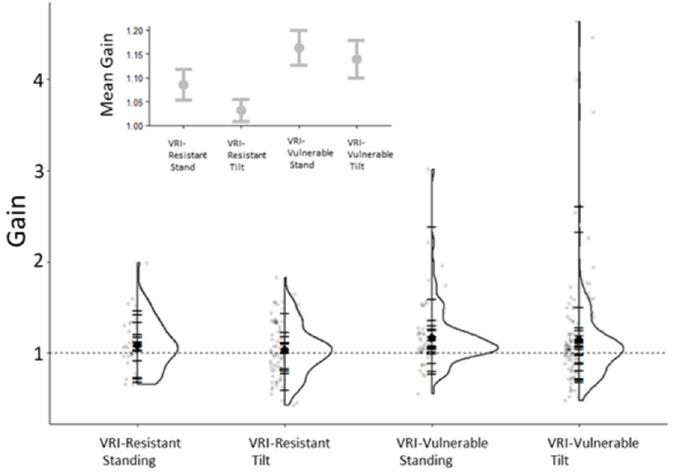
Fig 3. Gain by VRI type. The average gain for each participant is plotted as half violin plots where the width of the area under the line represents the proportion of data that is plotted there. The black horizontal lines display the means for each participant while the grey dots are individual data points. The horizontal dashed line shows unity gain (perfect performance). The insert shows the mean gain for each condition and the corresponding standard error.